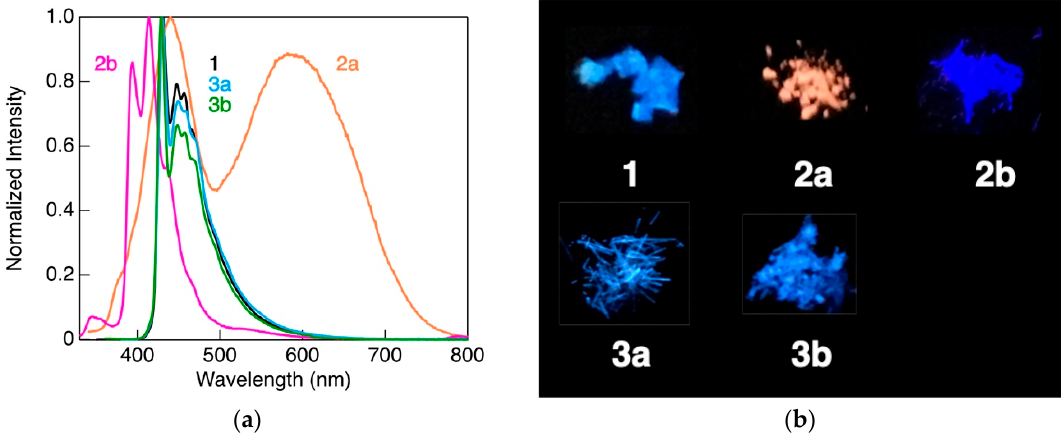
Figure 6. Photoluminescence spectra of Au complexes as crystals at room temperature in air. ( a ), luminescence spectra (black: 1 , λ ex = 290 nm; red: 2a , λ ex = 266 nm; orange: 2b , λ ex = 274 nm; blue: 3a , λ ex = 328 nm; green: 3b , λ ex = 335 nm). ( b ), Photographs of crystals taken under UV irradiation at 365 nm.